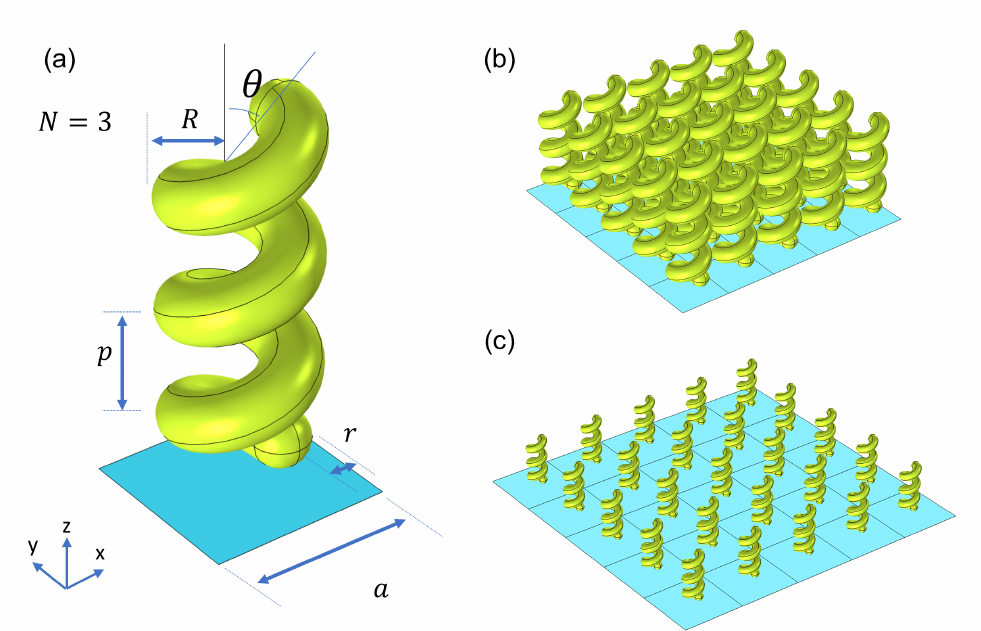
Figure 1. ( a ) The geometry of one lateral unit cell of the out-of-plane chiral structure composed of a right-handed Au helix on a glass substrate with the relevant structure parameters illustrated: the wire radius ( r ), helix radius ( R ), axial pitch ( p ), and the lattice constant ( a ). The out-of-plane periodicity is indicated by N . The geometry of the chiral metasurface for ( b ) a = 100 nm and ( c ) a = 250 nm.